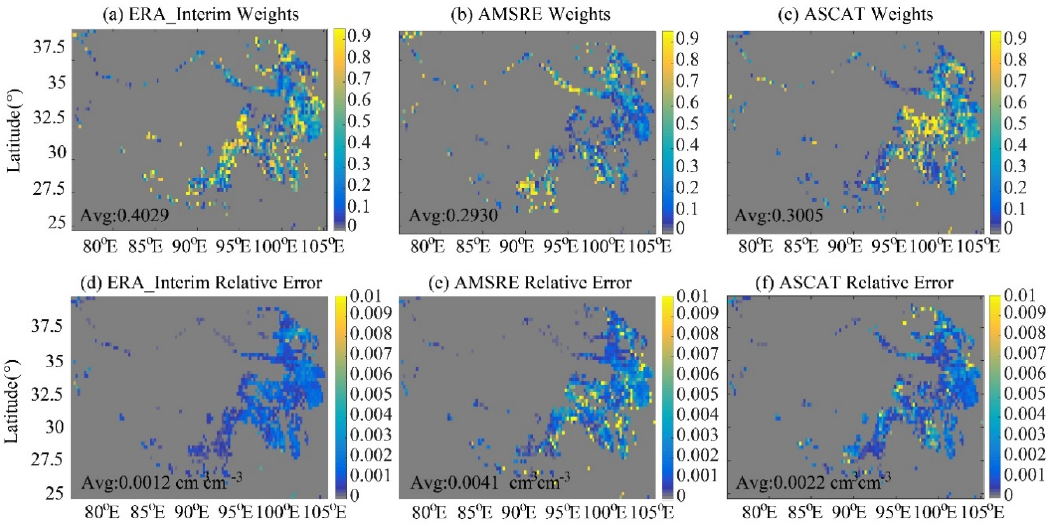
Figure 7. Weights and relative errors of the three scaled SM products for the blended SM: ( a , d ) ERA-Interim; ( b , e ) AMSRE; and ( c , f ) ASCAT.